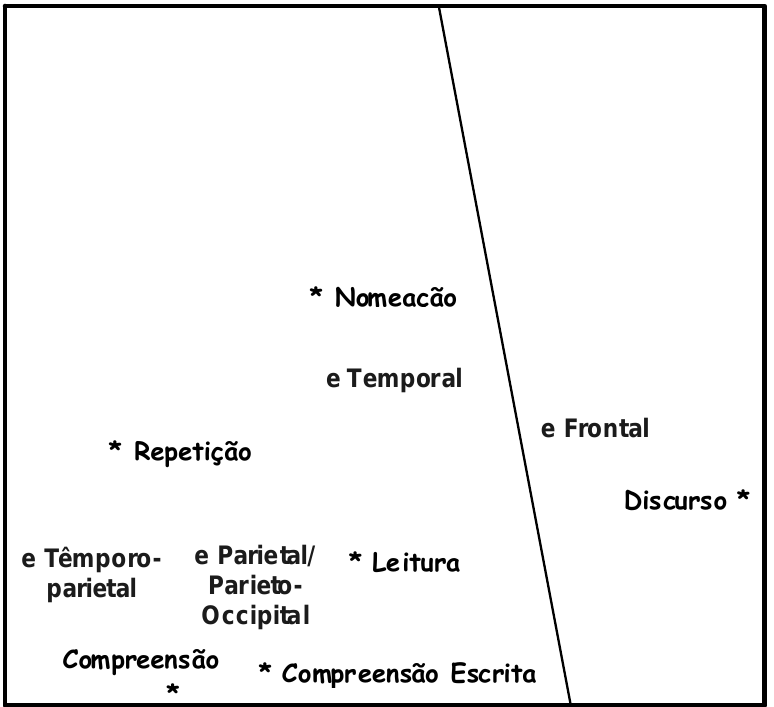
Figura 1 . Análise SSA da interrelação entre as tarefas de linguagem do teste de Mon- treal-Toulose (variáveis de conteúdo “*”) e as lesões corticais no hemisfério esquerdo (variáveis externas “e”). Nota . Coeficiente de Alienação - 0,01; Projeção